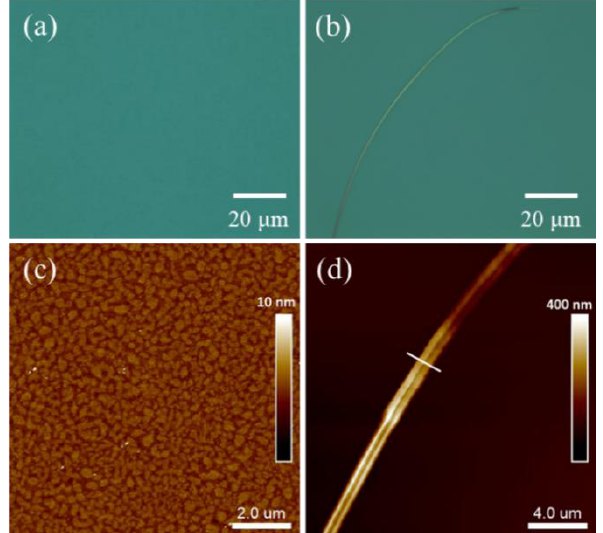
Figure 3. ( a , b ) Optical microscope images and ( c , d ) AFM images of spin-coated nanostructures with 1:20 mass ratios of PDI 8 -CN 2 / PMMA at a total concentration of 5mg/mL on Si/SiO 2 substrate ( a , c ) before and ( b , d ) after the SVA process.